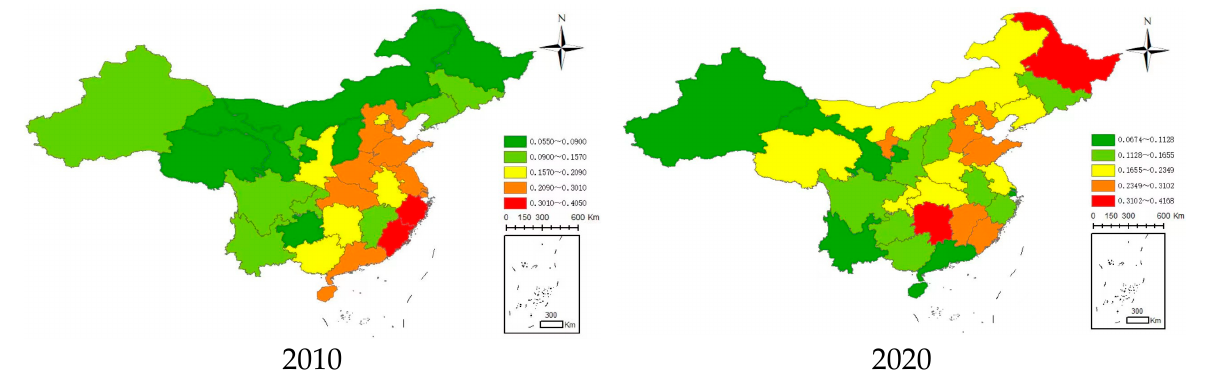
Figure 1. Spatial distribution of ANSP in 2010 and 2020.